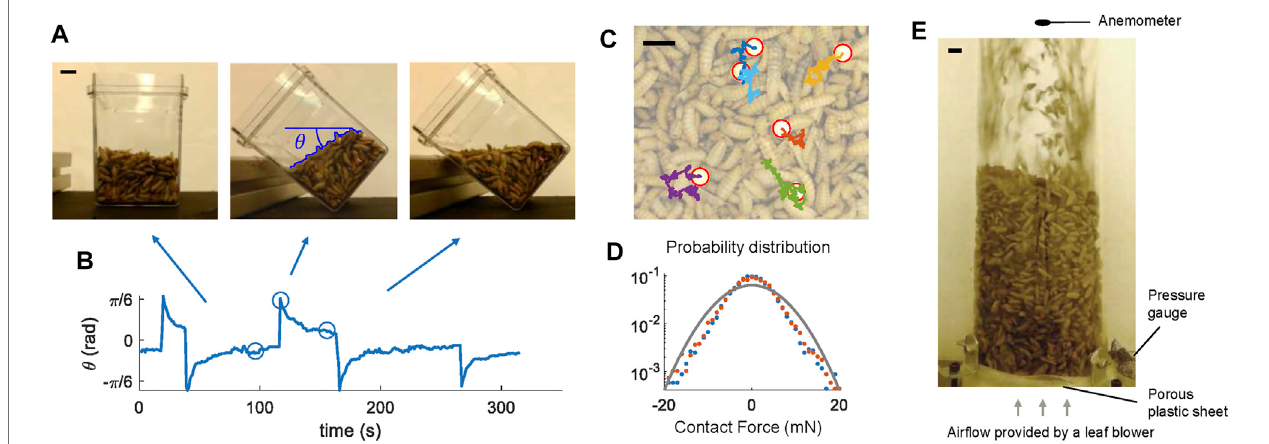
FIGURE1| Aggregatesofliveblacksoldier fl ylarvaeshow fl uid-likebehaviors. (A) Larvaaggregates fl owandlevelwiththehorizonasthecontaineristilted. (B) The orientation of the larva aggregate surface with respect to the horizon. The circles represent the snapshots in (A) . (C) Plastic spheres in the larva aggregates undergo Brownian motion. Red circles mark the locations of the plastic spheres, and colored lines show their tracked trajectories. (D) The probability distribution of translational forces on the plastic spheres. Blue dots and red dots show the force component in the x and y direction, respectively. The gray line shows a Gaussian distribution with a standard deviation of 6.3 mN. (E) Side view of the fl uidization chamber. Scale bars are 1 cm long in all sub fi